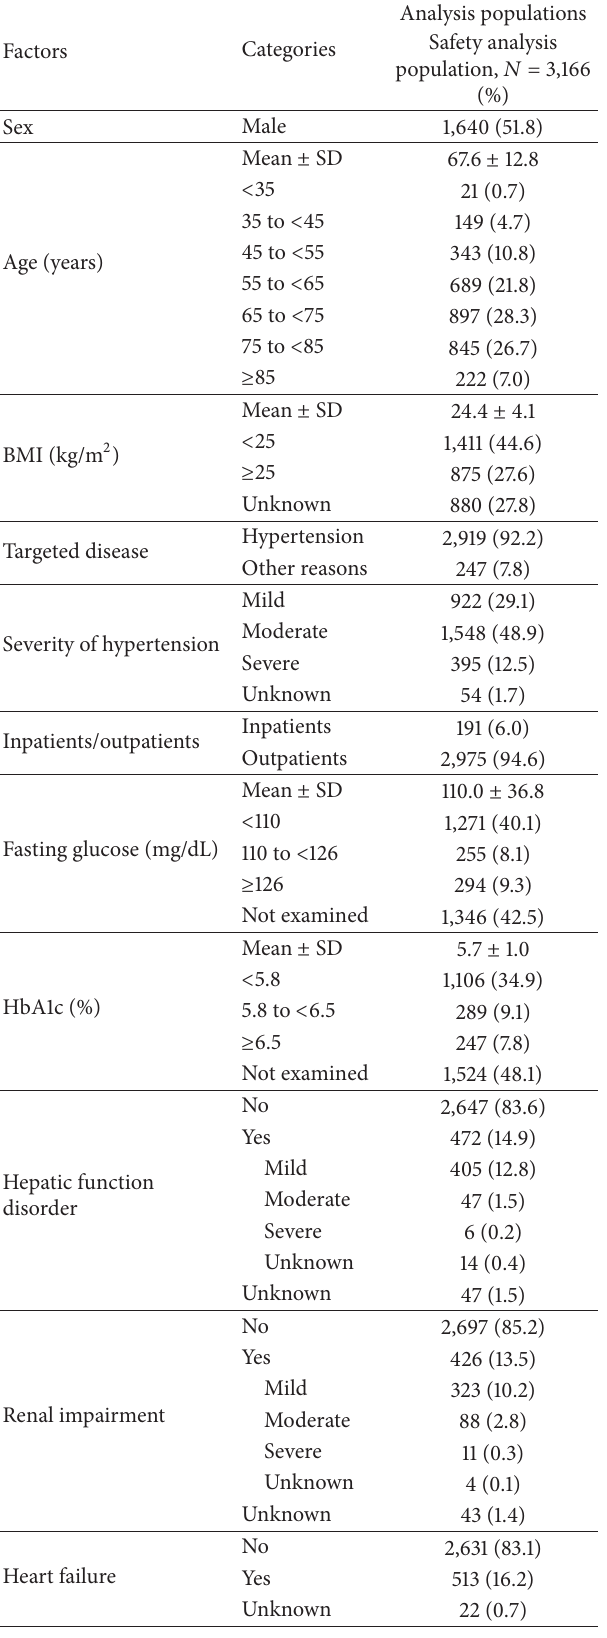
Table 1: Patient